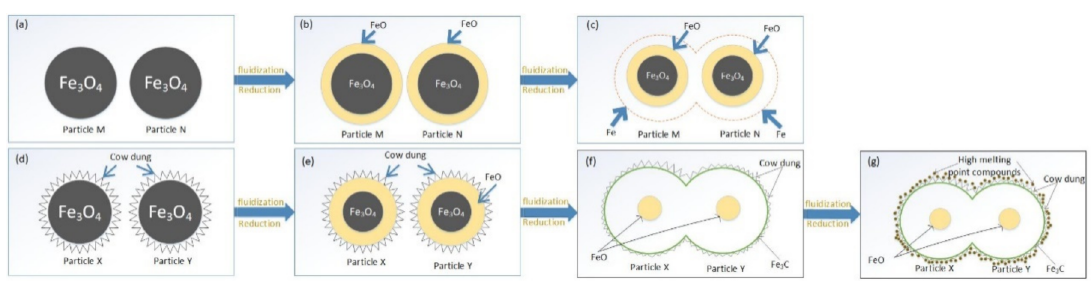
Figure 14. Reduced iron ore powder particles and restraining mechanism schematic